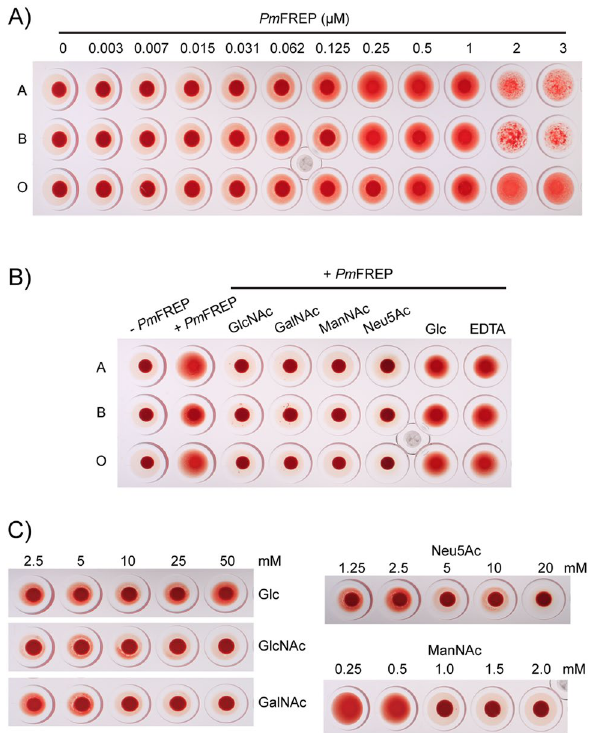
Figure 7. Agglutination of human red blood cells with His 6 Pm FREP. ( A ) Agglutination of different ABO blood type by His 6 Pm FREP at various concentrations. ( B ) Inhibition of ABO blood type agglutination by different carbohydrates (20 mM for Neu5Ac and 50 mM for other carbohydrates) and EDTA. ( C ) Inhibition of A blood type agglutination by different carbohydrates at various